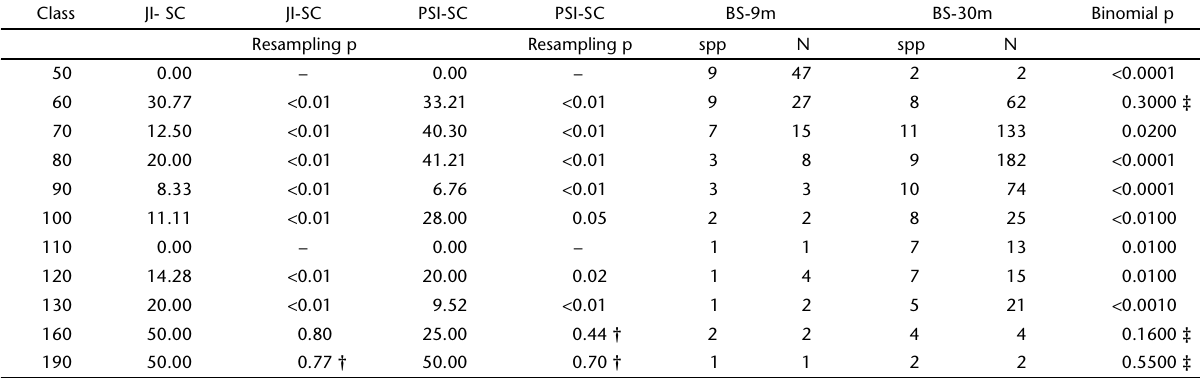
Table II. Indexes of faunistic similarity (Jaccard Index – JI and Percent Similarity Index – PSI) with significance values (resampling with replacement; N = 5000), comparative values of richness (spp) and absolute abundance (N) and significance on success rate (Binomial p) of size classes with catch overlap between beach seine nets.